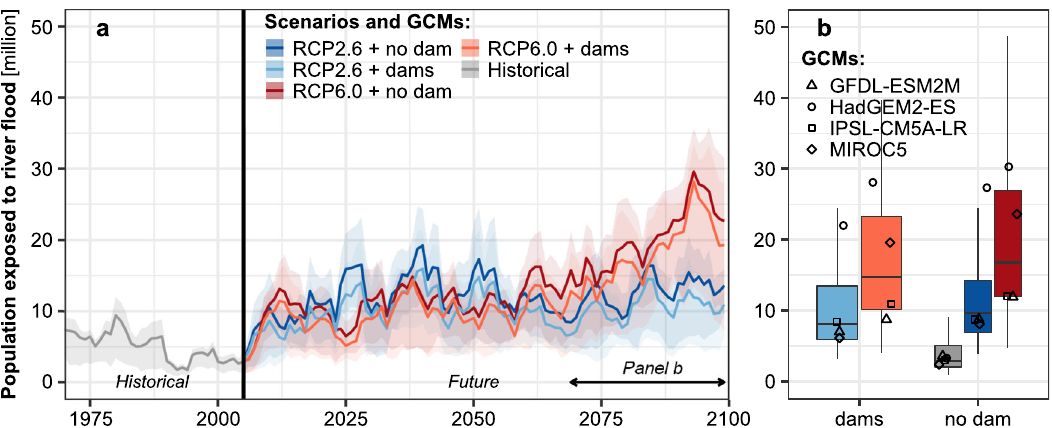
Fig. 1 Population exposure to the historical 100-year river fl ood (keeping population constant at 2010 level) downstream of dams. a 5-year moving averages of the population living below dams exposed to the historical 100-year river fl ood for historical (grey line) and future simulations for 2 RCPs and experiments (colour lines). The uncertainty range represent the spread among GCMs. b The 95 th and 5 th range (whiskers), median (horizontal lines in each bar), and 1 st and 3 rd quartiles (height of box) and individual mean values among GCMs (markers) of the population exposed to the historical 100-year fl